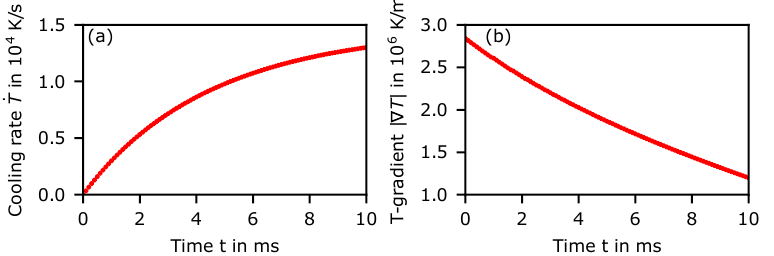
Figure A4. The time from the turning point over the ( a ) cooling rate and ( b ) temperature gradient found in numerical simulation along the solidification pathway defined in Figure A2.